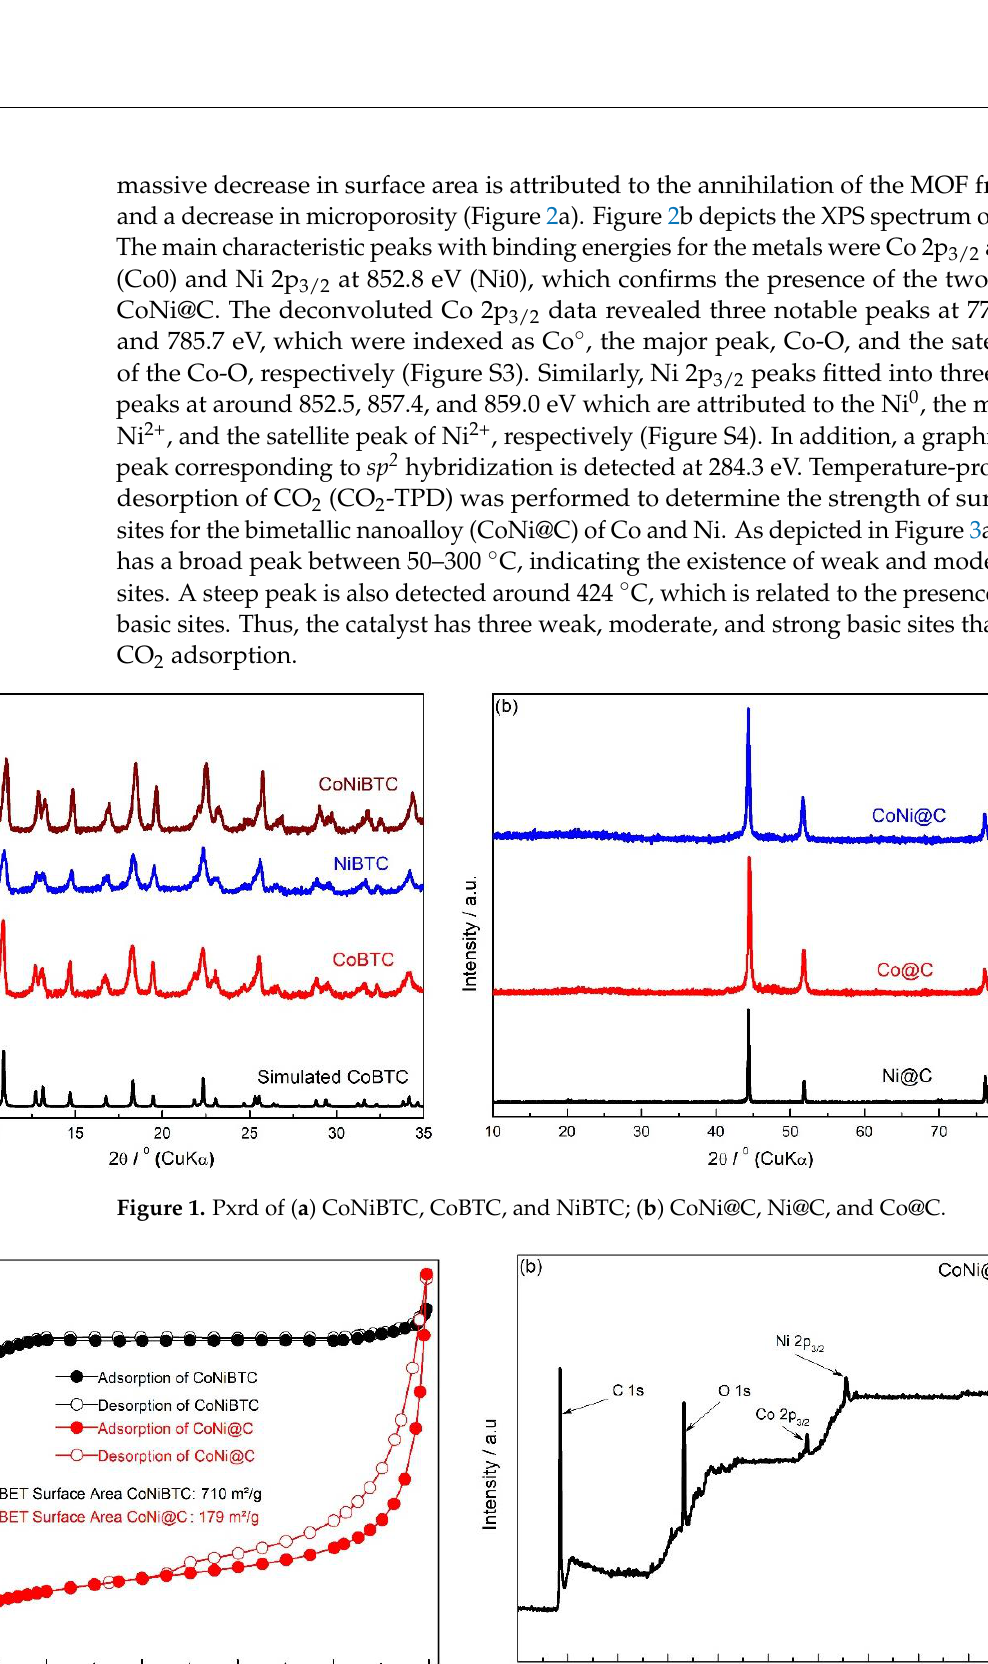
Figure 3. ( a ) CO 2 -TPD; ( b ) H 2 -TPR of CoNi@C. Temperature-programmed reduction with hydrogen was used to determine the reducibility behavior of the Co and Ni bimetallic nanoalloy (CoNi@C). As reported previously, the presence of Ni in the Ni-Co alloy enhances the reducibility of the Cobalt [33]. As depicted in Figure 3b, a huge, broad peak centered at 590 °C was observed between 400–850 °C, indicating mixed CoO and NiO reduction to metals leading to more reducible species. FESEM data of the CoNiBTC showed hexagonal-shaped layered microcrystalline materials (Figure S5). EDX and elemental mapping analysis revealed that the Co/Ni ratio in the CoNiBTC MOF was 3:2 (Figure S6), which supports the ratio determined by the ICP-MS. TEM images of CoNi@C revealed a consistent distribution of Co-Ni nanoalloy with a size between 5 and 10 nm encased by a carbon layer. There was no discernible aggregate formation detected. Additionally, the particle lattice’s average interplanar spacing was 0.21 nm, which is equivalent to the lattice spacing of nanoparticles made of the Co-Ni alloy (Figure 4) [34]. EDX analysis of the two bimetallic MOFs CoNiBTC-1 and CoNiBTC-2 indicated that the Co/Ni ratio was 1:1 in CoNiBTC-1 and 2:3 in CoNiBTC-2 (Figures S7, S8, S9 and S10.) Thus, from these MOFs, three bimetallic nanocatalysts with varying Co/Ni ratio, including CoNi@C (3:2), CoNi@C-1(1:1) and CoNi@C-2(2:3) were prepared.